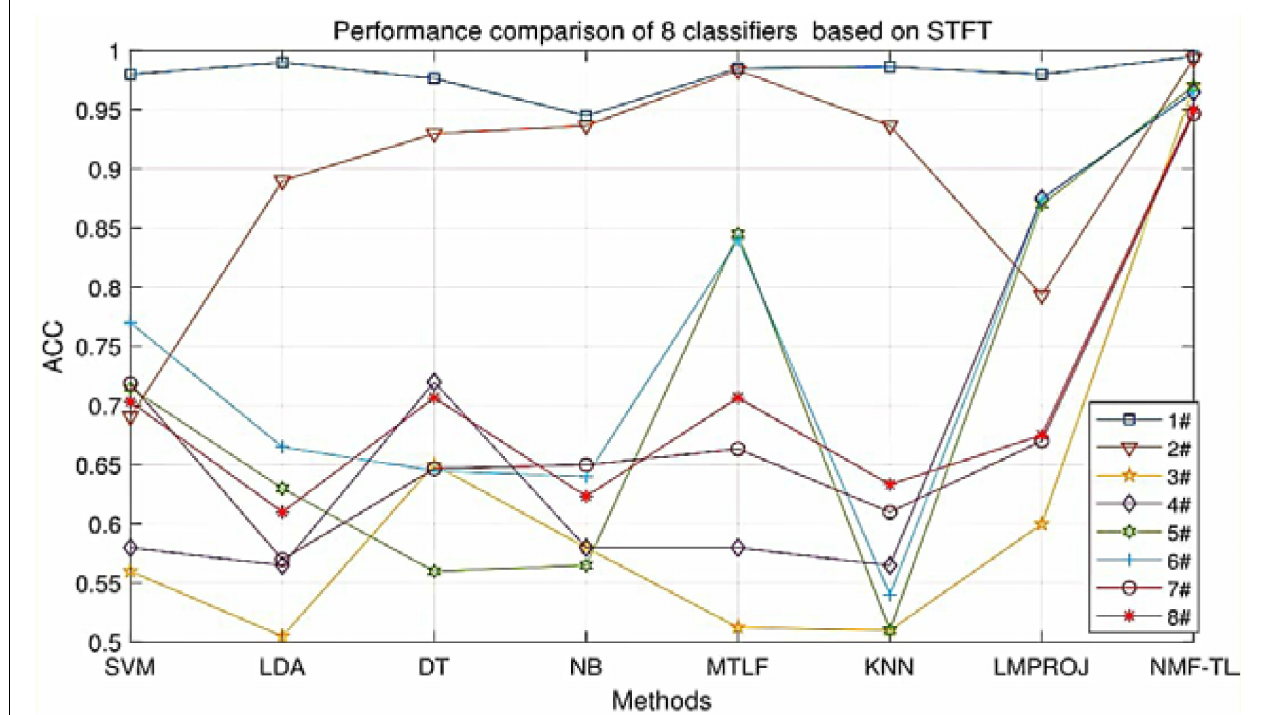
FIGURE 5 | Classification accuracy comparison of 8 classifiers on datasets based on SIFT feature extraction.